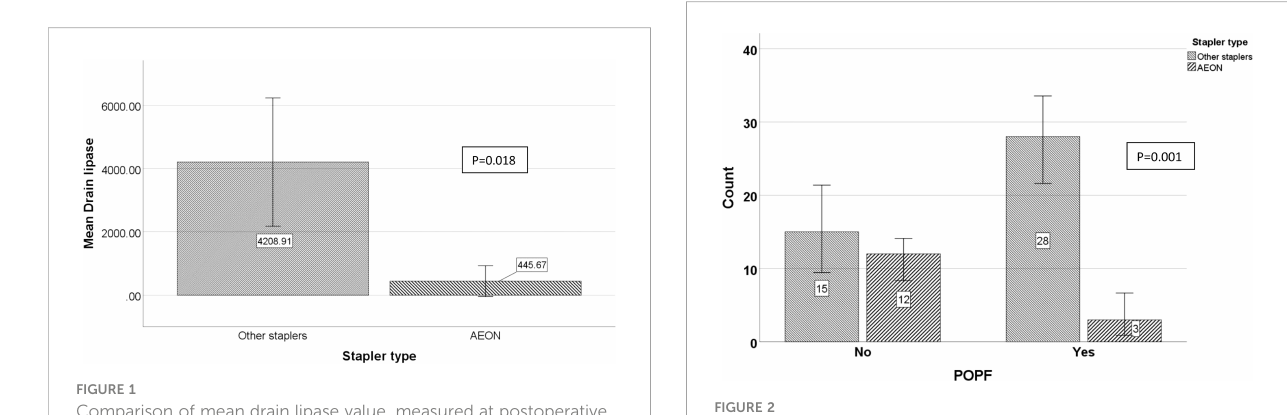
FIGURE 1 Comparison of mean drain lipase value, measured at postoperative day 3, between AEON and the other stapler used for pancreatic transection. Mean drain lipase at postoperative day 3 was signi fi cantly higher in patients having their pancreas divided with other instrument (4,209 U/L) versus AEON (446 U/L); 95% con fi dence intervals are shown.